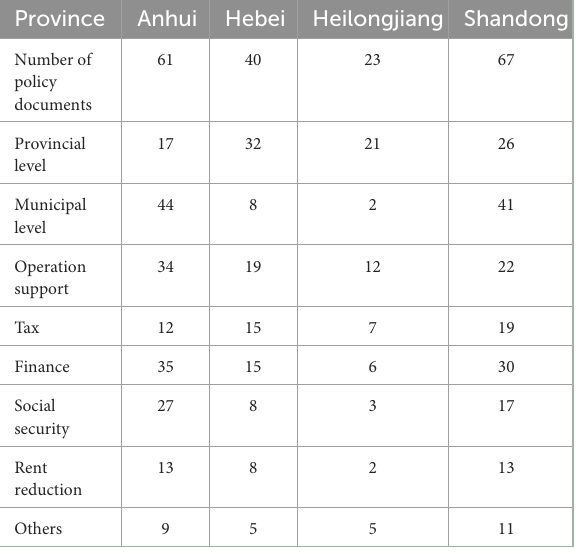
TABLE 5 Number of government policy documents to support resumption of work and production by mid March,